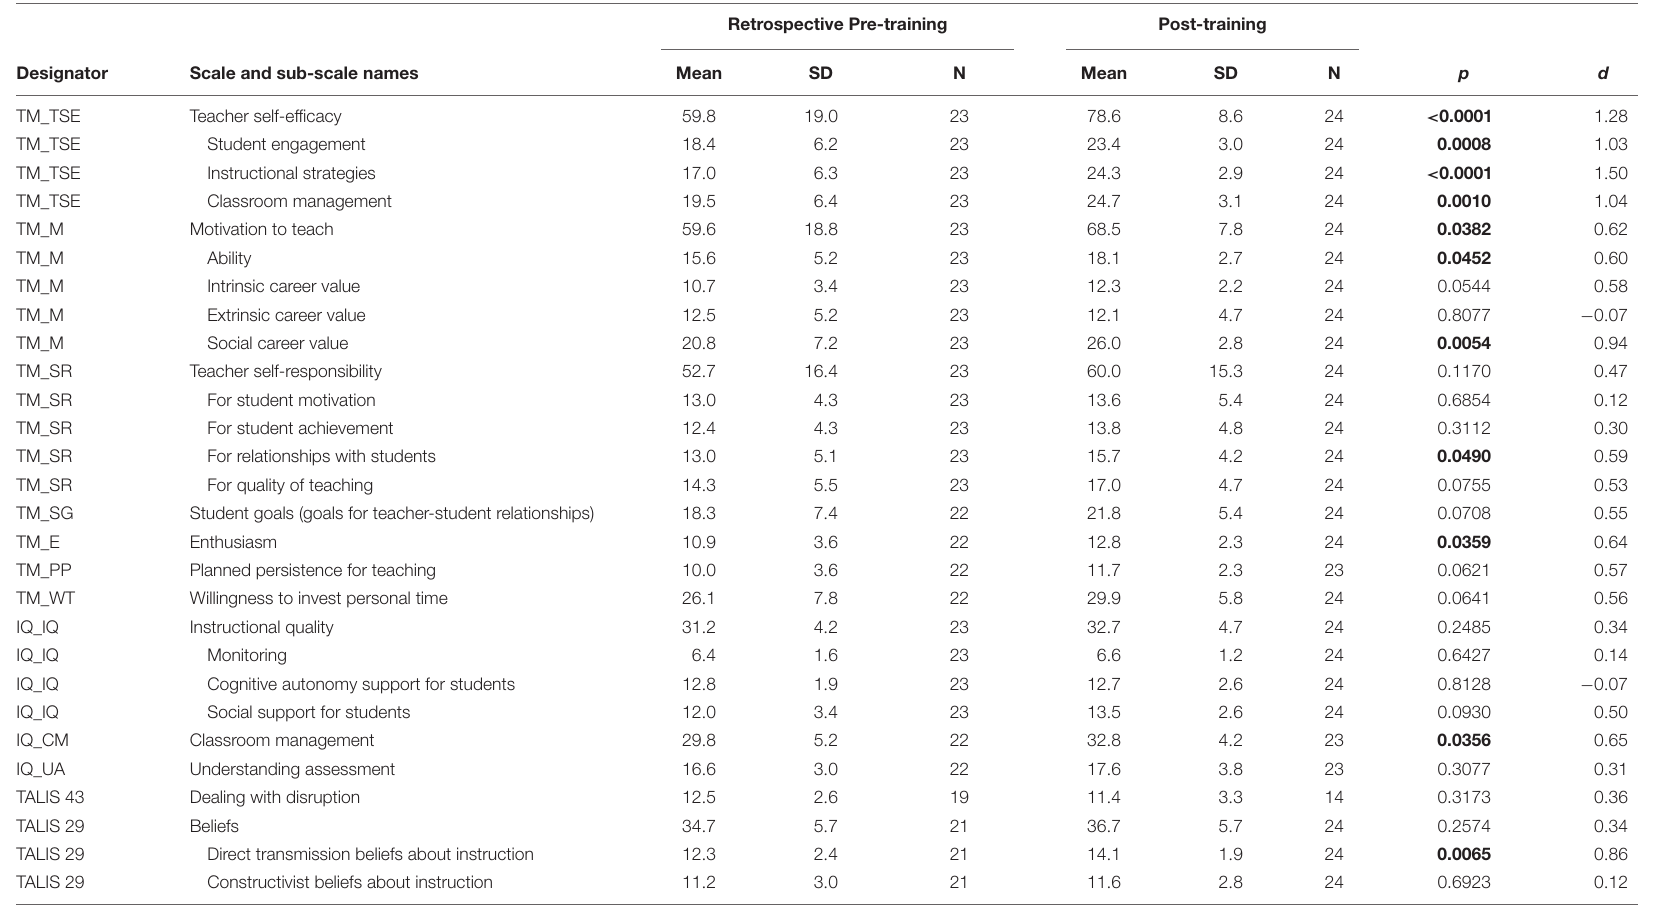
TABLE 2 | OECD Scales included in the Tier I teacher survey.